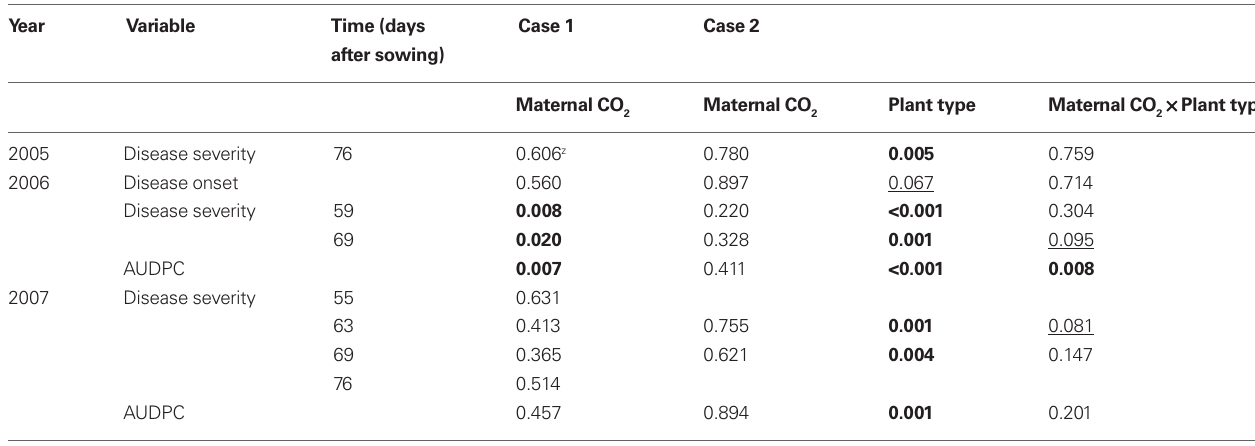
Table 4 | Probability ( P ) values from mixed-model AnOVA of disease severity and area under disease-progress curve (AuDPC) in the experiments of 2006 and